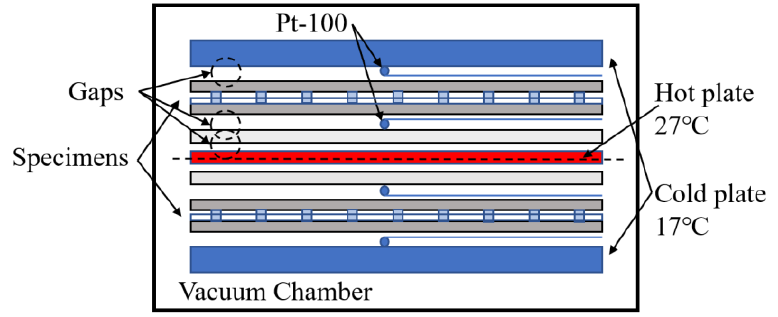
Figure 11. Schematic of the guarded hot plate apparatus.